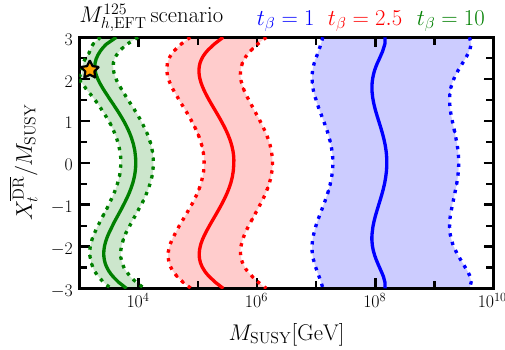
Fig. 2 Contour lines of M h (cid:7) 125GeV ( solid ) and M h (cid:7) 122 , 128GeV ( dashed ) as a function of M SUSY and X DR t / M SUSY , for tan β = 1 ( blue ), tan β = 2 . 5 ( red ) and tan β = 10 ( green ). M A is fixed to 1 TeV. All remaining parameters are as in the M 125 orange star marks the approximate position of the M 125